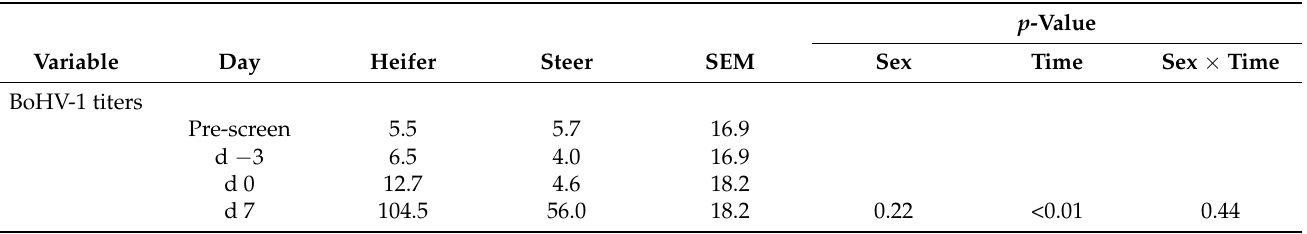
Table 1. Bovine herpesvirus-1 (BoHV-1) serum titers in heifers and steers exposed to a dual viral– bacterial respiratory disease